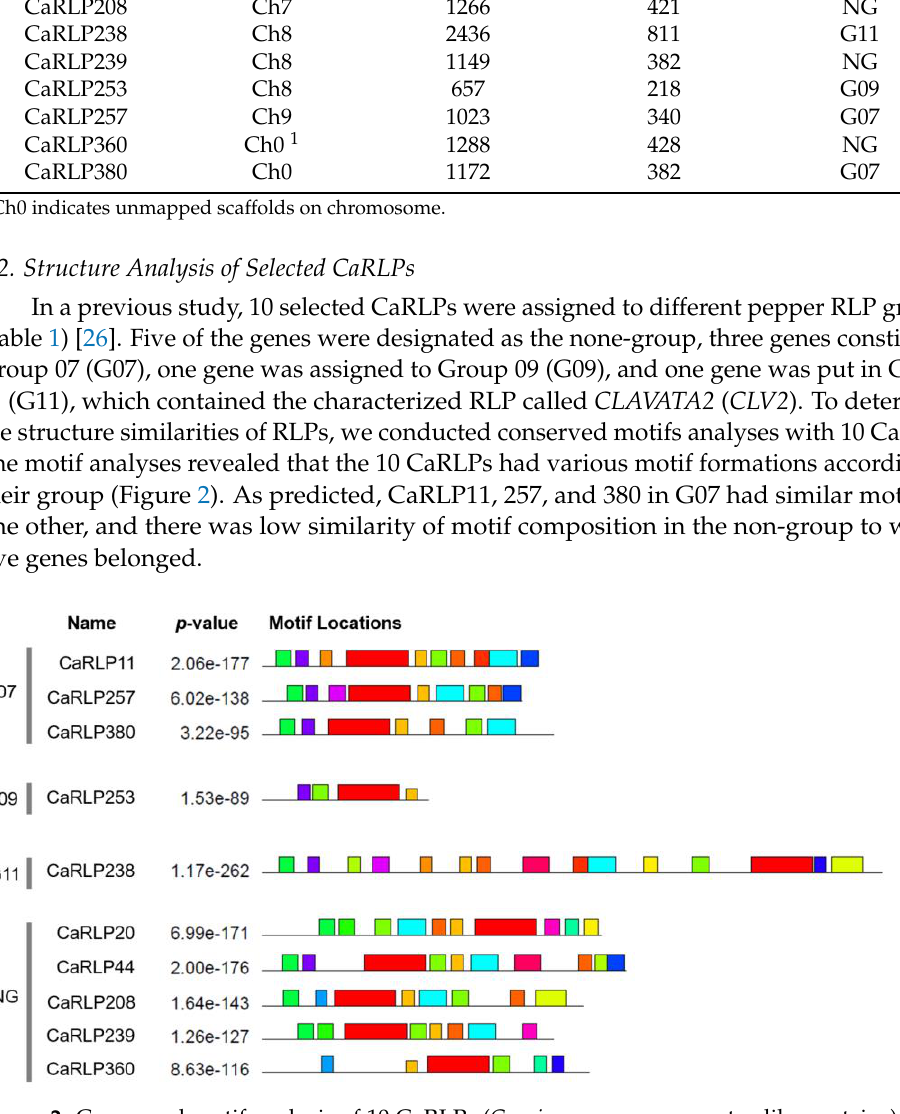
Figure 2. Conserved motif analysis of 10 CaRLPs ( Capsicum annuum receptor-like proteins). Con- served motifs of the 10 selected CaRLPs were analyzed using the MEME program. The left side of the gene name represents the CaRLP group to which each CaRLP belongs. Each color box in motif locations displays different motifs.